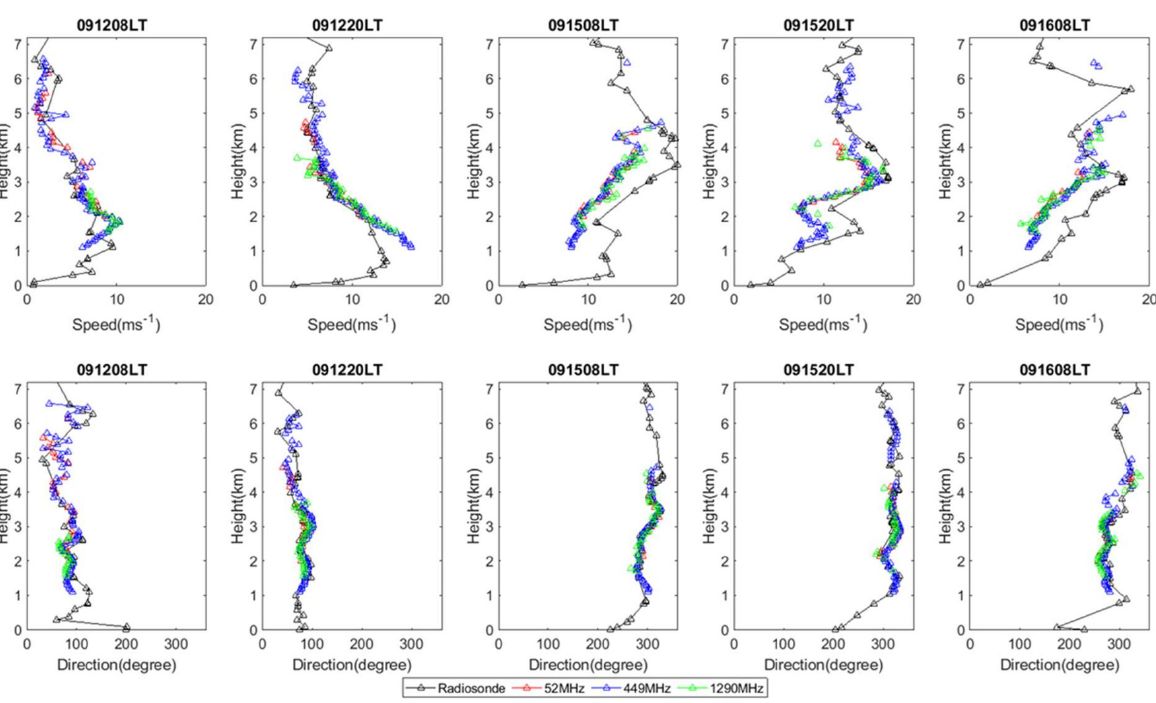
Figure 6. Comparisons of the horizontal wind velocities ( upper panels) and wind directions ( bottom panels) measured by 52 MHz radar (red curve), 449 MHz wind profiler (blue curve), 1290 MHz profiler (green curve), and radiosonde (black curve) in clear air